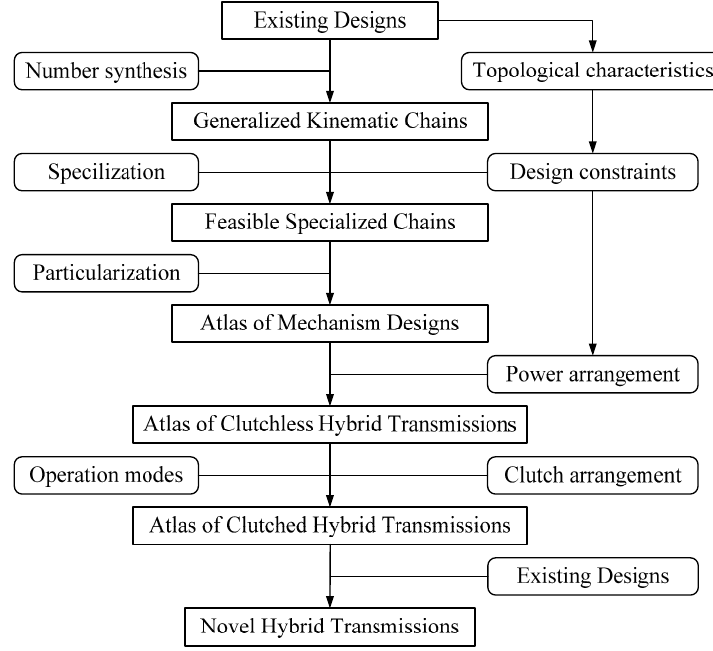
Figure 1. Procedure of configuration synthesis.